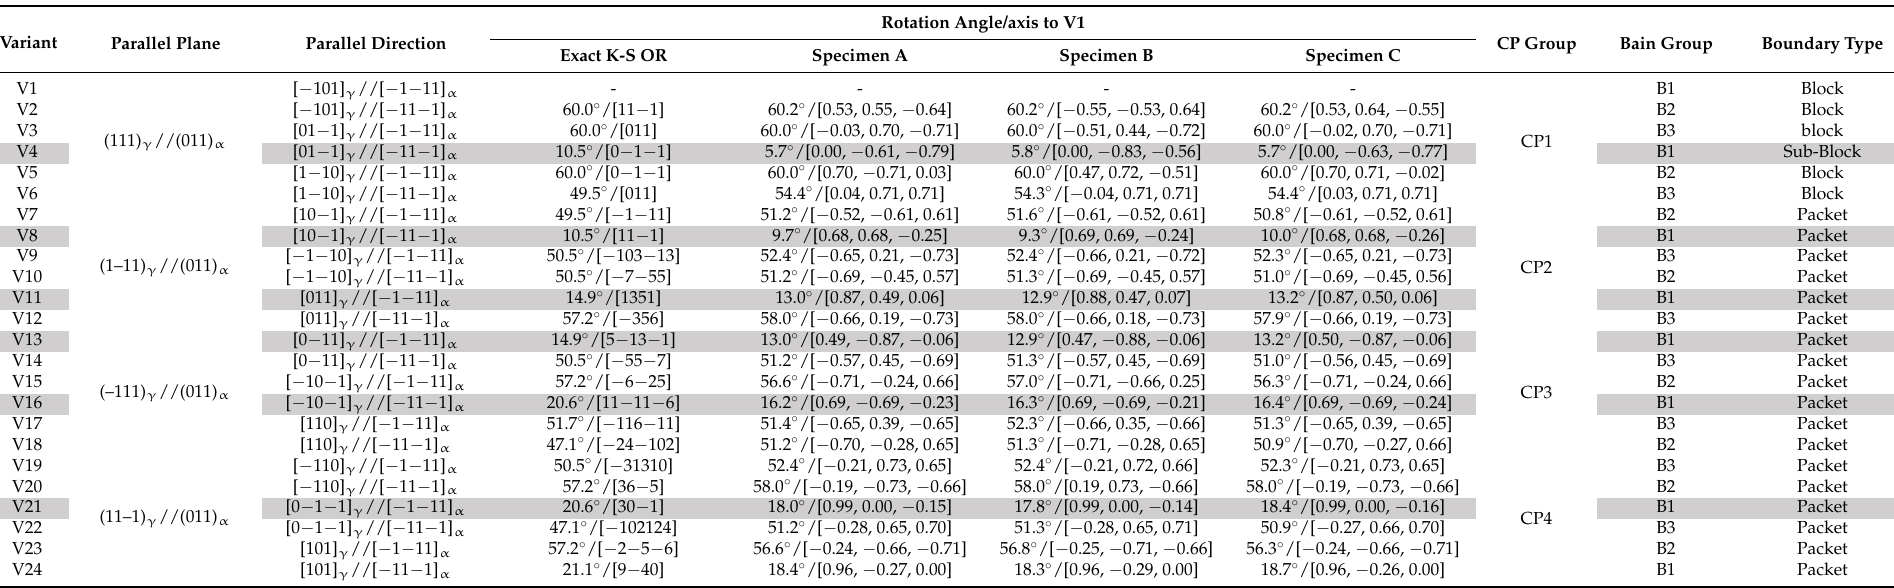
Table 4. Misorientation axes and angles of V1 to the other variants calculated from the experimentally determined OR (actual OR) and the inter-variant boundary